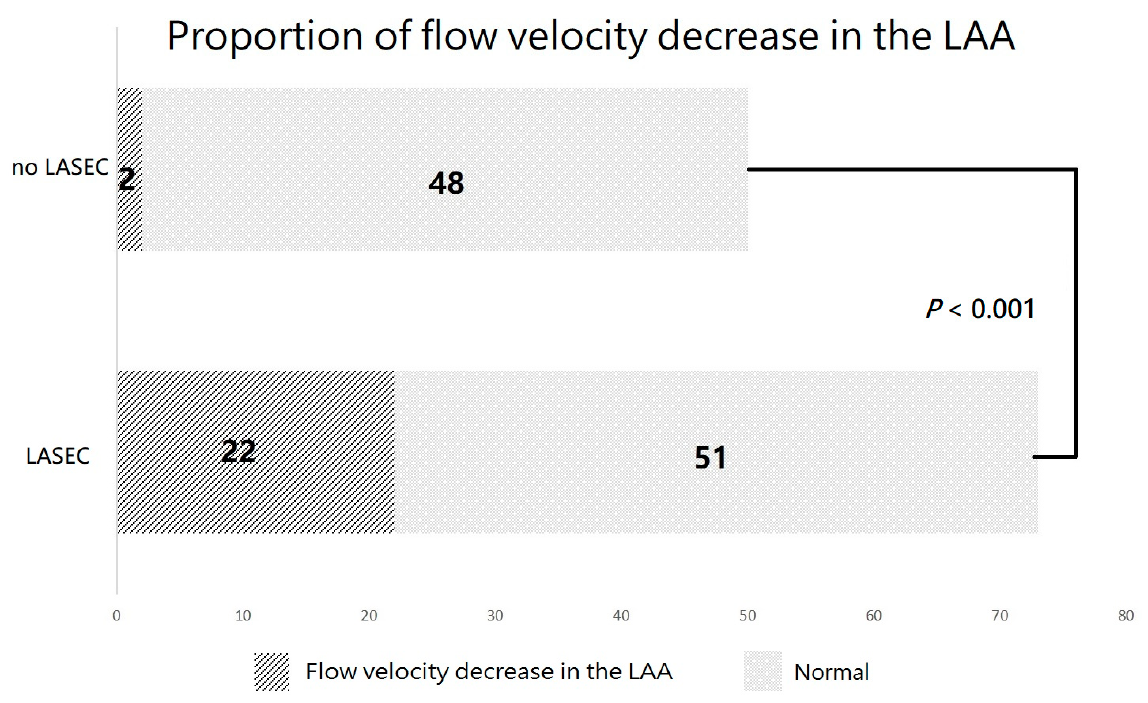
Figure 2. The proportion of the flow velocity decrease in the LAA was higher in the LASEC group than in the no LASEC group (30.1% vs. 4%, p < 0.001). LAA, left atrial appendage.